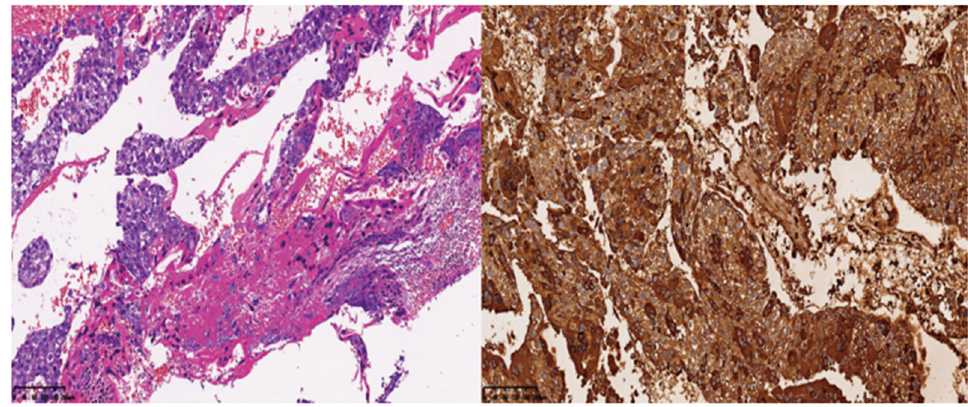
Figure 4. Pathological image of the spleen and immunostaining of hCG.